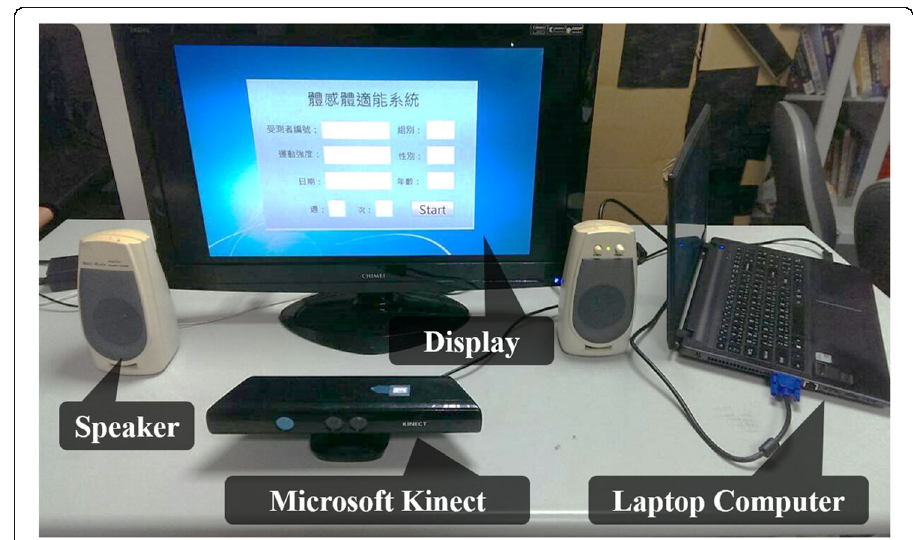
Fig. 9 The hardware of the adaptive exercising